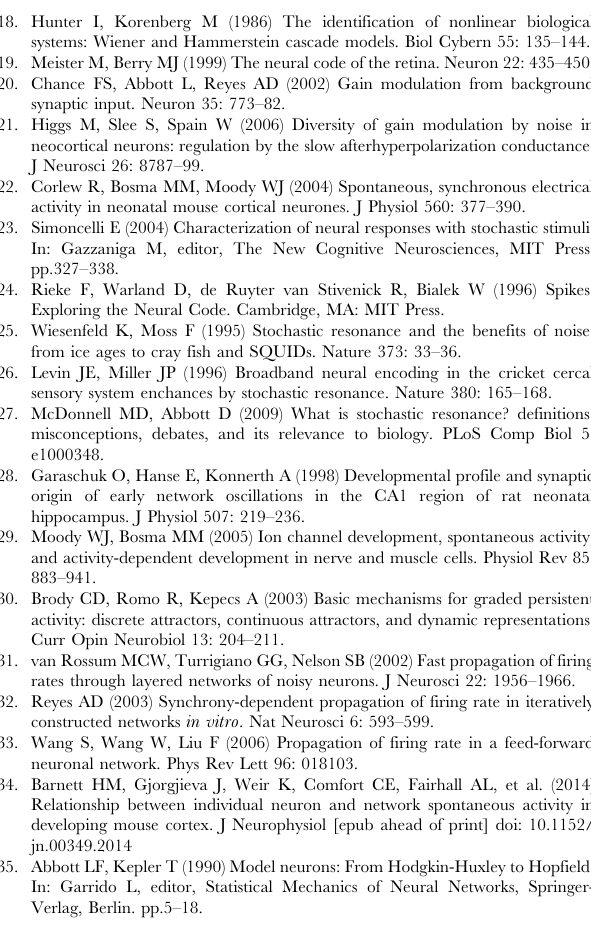
Figure S3 Firing rate transmission for a range of noise amplitudes s . Top: The f – I curves for gain-scaling and nongain-scaling networks with different G Na = G K and for different levels of noise ( s ~ 15,25,35,50 , and 75 pA). We considered gain- scaling networks with G Na = G K ~ 1 : 5 and A . weak vs B . strong- connectivity, C . gain-scaling networks with G Na = G K ~ 1 : 0 and strong connectivity, and D . nongain-scaling networks with G Na = G K ~ 0 : 6 and strong connectivity (as weak connectivity was insufficient to drive activity in these networks). The black lines denote the linear input-output relationships derived from the mean field, which predict how the mean output firing rate of a given network layer can be derived from the mean input current into that layer with the standard deviation of the prediction shown